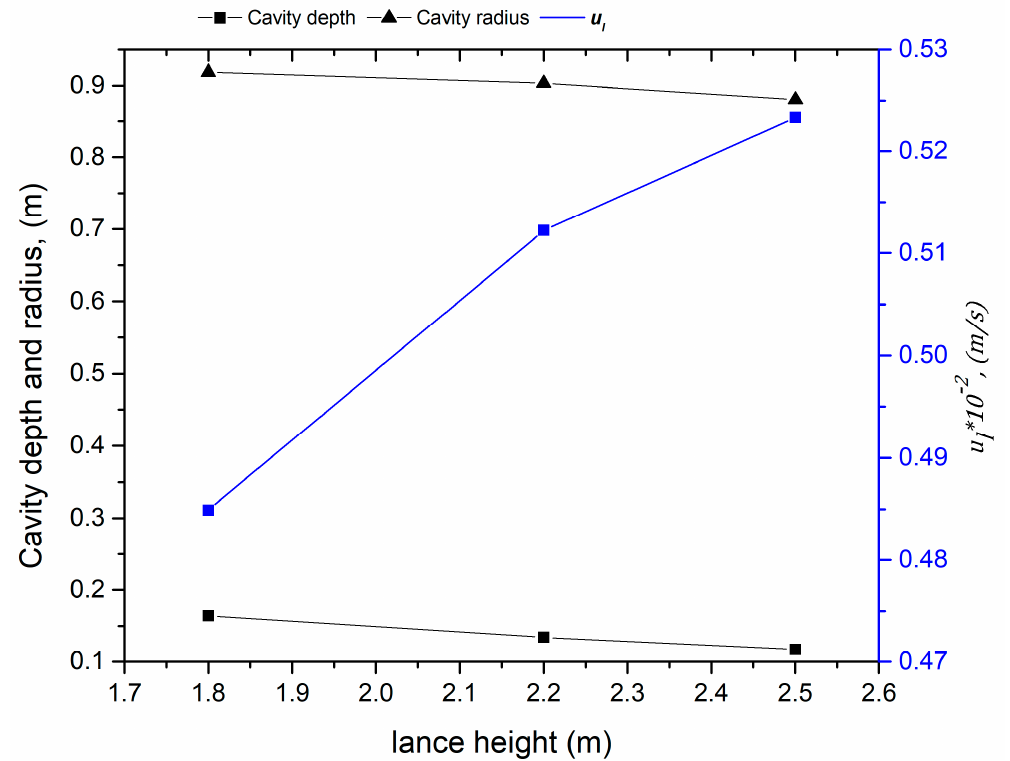
Figure 4. Change of cavity dimensions and surface velocity at various lance heights.